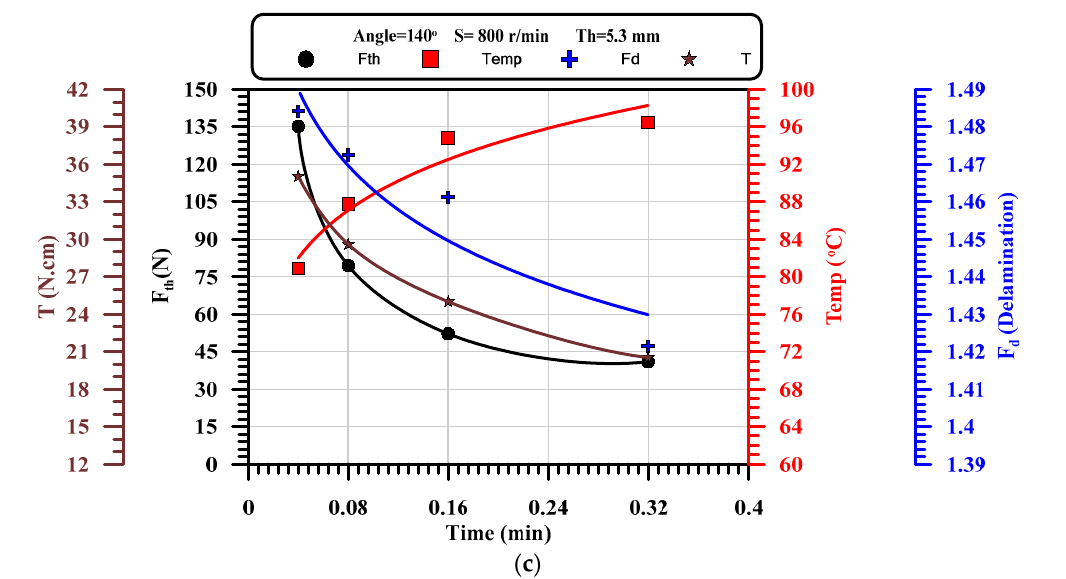
Figure 10. The effect of machining time on thrust force, torque, delamination, and temperature at constant speed and thickness and different point angles, ( a ) At thickness of 5.3 mm and speed = 800 r/min, Angle = 100 ◦ ; ( b ) At thickness of 5.3 mm and speed = 800 r/min, Angle = 118 ◦ ; ( c ) At thickness of 5.3 mm and speed = 800 r/min, Angle = 140 ◦